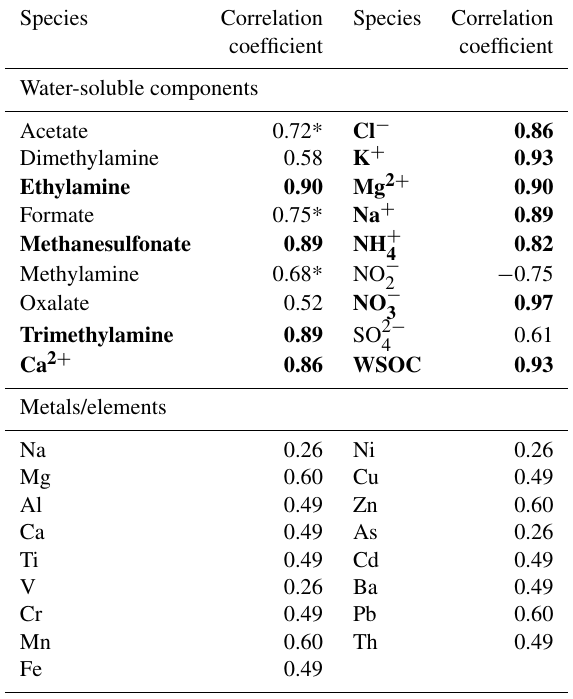
Table 1. Spearman rank correlation coefficients between per- volume concentrations of water-soluble species as well as met- als/elements in the fog water samples and the corresponding ROS levels. Correlation coefficients which were statistically significant (at P< 0 . 05) are highlighted in